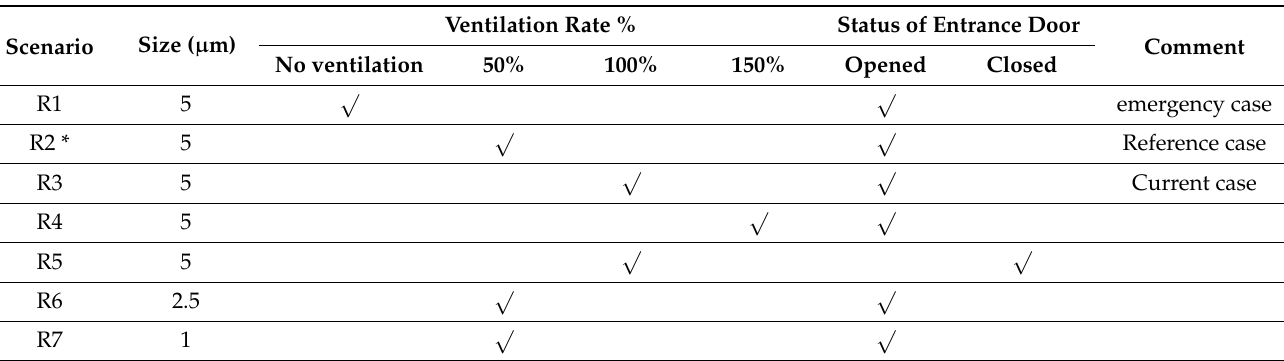
Table 2. Characteristics of the conducted numerical